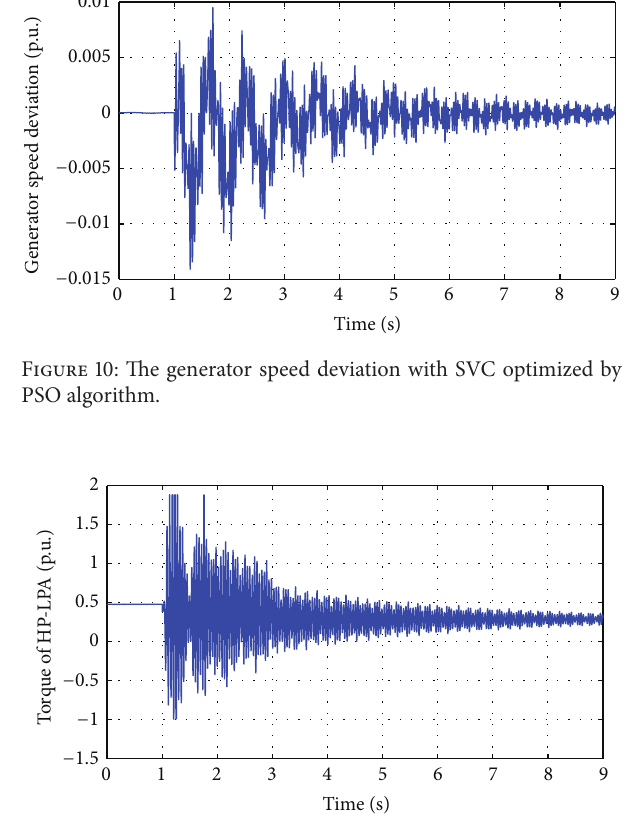
Figure11: Theinhibitoryeffect ofSVC optimized by PSOalgorithm.